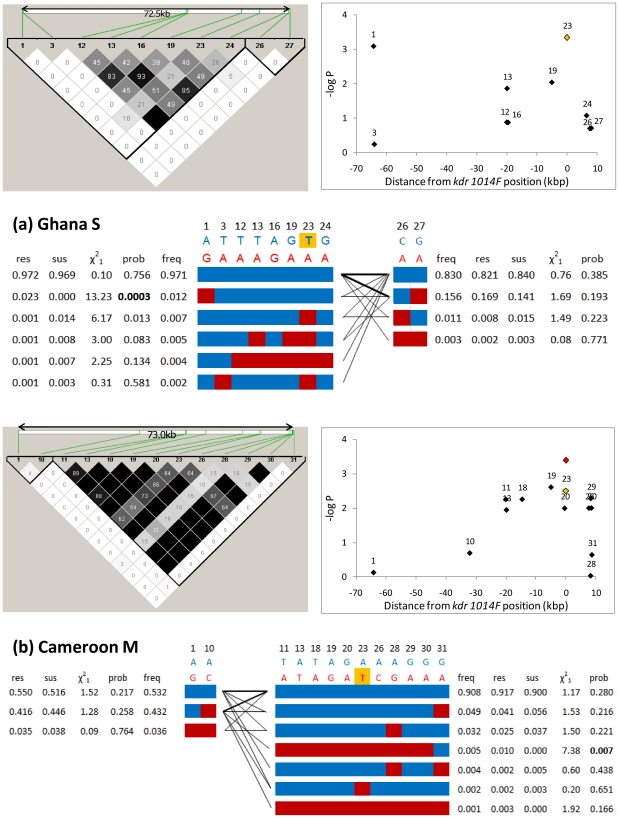
Sodium channel association analyses.Upper left panels in (a) and (b) show pairwise linkage disequilibrium (values are r2); green lines show SNP positions on linear scale). Block divisions are created simply to reduce the number of haplotypes by separating highly polymorphic peripheral SNPs from the rest of the (low MAF) SNPs. Upper right panels in (a) and (b) show single SNP association analysis for the sodium channel. Lower panel shows resultant haplotypes for each block with their interconnections (thick lines indicate connection frequency>10%). Total frequencies (freq), frequencies in resistant (res) and susceptible (sus) mosquitoes and haplotype association test statistics are shown. Colours in haplotypes correspond to base colours shown above (kdr L1014 is highlighted in gold). SNP nomenclature is consistent across plots, with absent numbers monomorphic. In (b) recalculation of single SNP association statistics considering only individuals possessing typical kdr (red block-dominated) haplotypes results in the strongest association of kdr L1014 (red point in upper left plot).